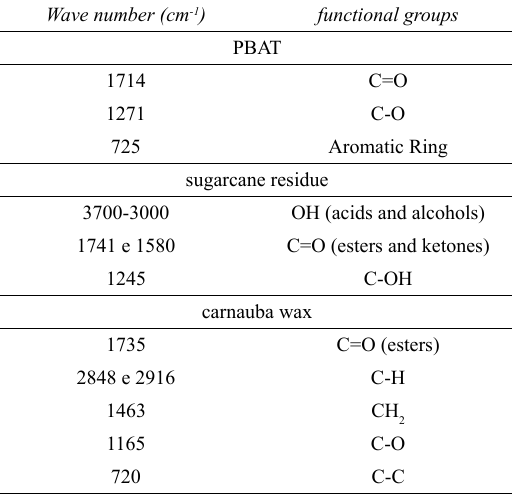
Table 4. Wave number and functional groups of PBAT, sugarcane residue, and carnauba